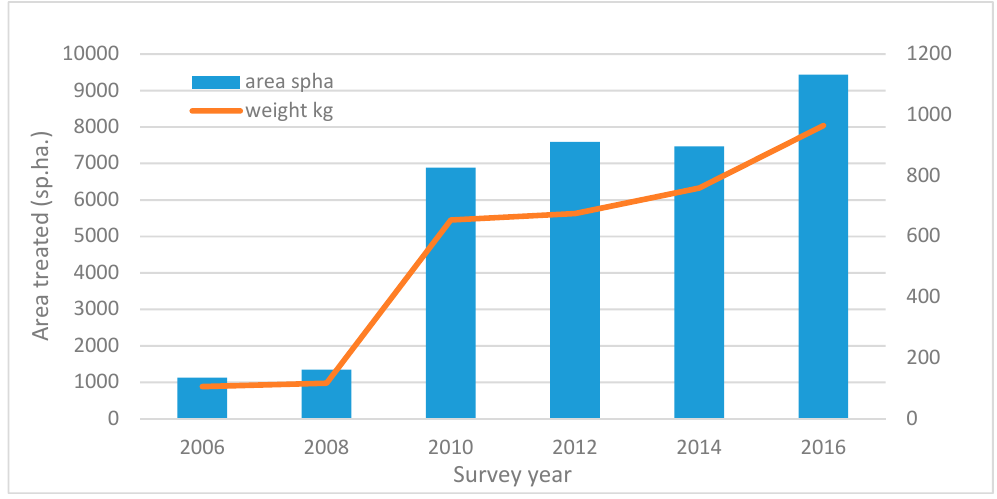
Figure 8. The application area treated (sp.ha.) and weight (kg) of neonicotinoid active substances applied as seed treatment to arable crops in Northern Ireland between 2006 and 2016.